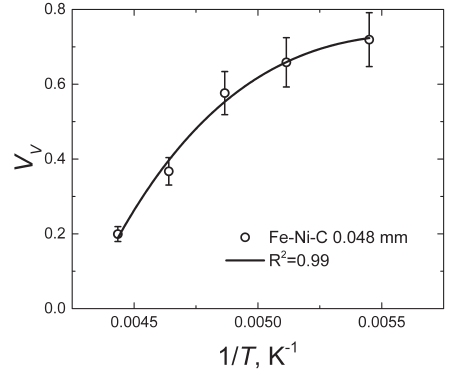
Fig. 8 – Volume fraction of martensite plates per unit of volume against transformation temperature. Fe-32wt%Ni-0.004wt%C alloy 5 with a mean intercept length of austenite grains equal to 0.048 mm. Solid line corresponds to the model developed here: equation 9. Error bars corresponding to an estimated relative error of ±10% were added to the